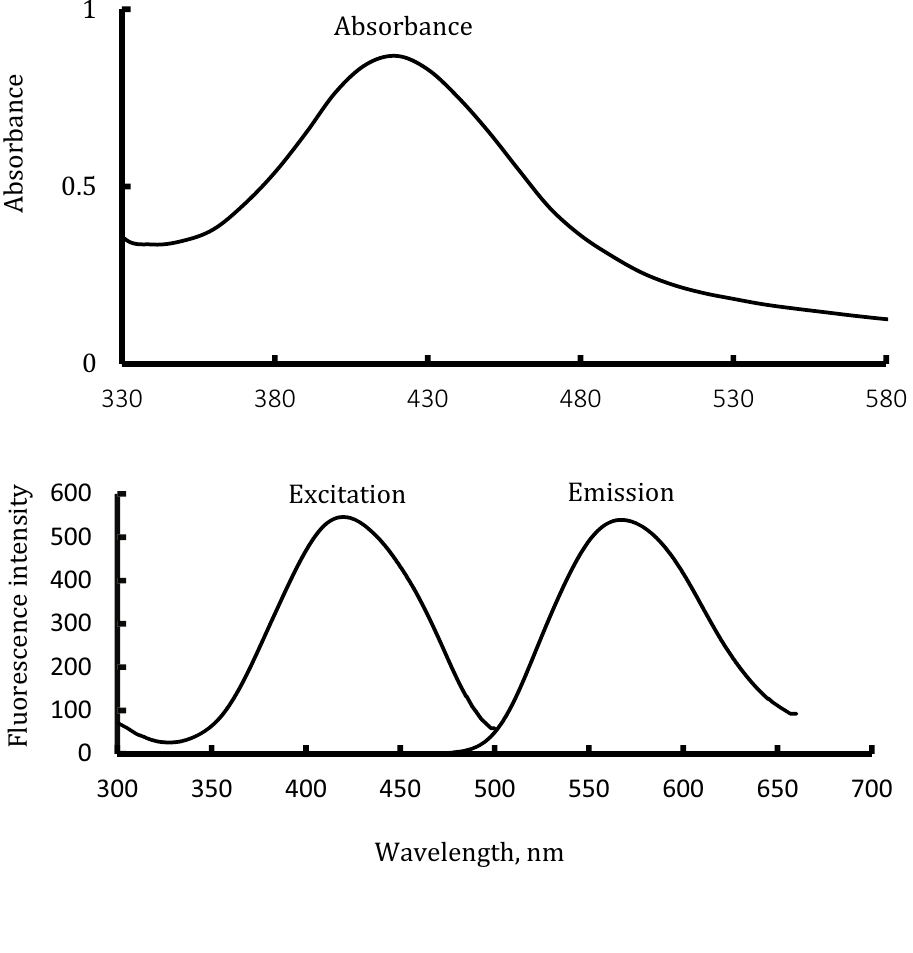
Figure 2. Examining the peroxidase mimicking activity for the prepared PVP-Ag-NPs by forming the characterized absorption and fluorescence (excitation/emission) spectra of OPDA reaction product